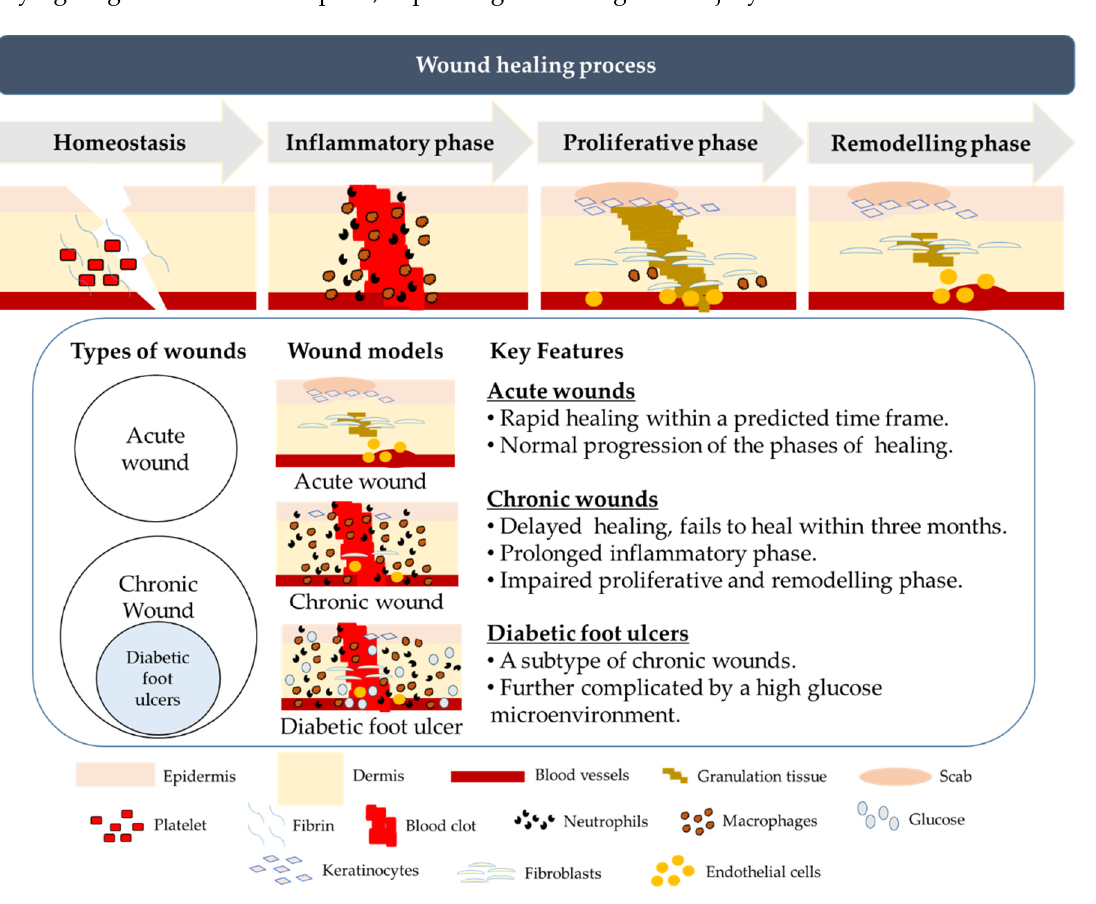
Figure 1. An illustration of the different phases of cutaneous wound healing and the key differences between acute wounds, chronic and diabetic foot ulcers. In normal wounds, healing is initiated by hemostasis to minimize further blood loss, followed by the inflammatory phase to prevent microbial infection. In the proliferative phase, granulation tissue is formed accompanied by the proliferation of epidermal keratinocytes and dermal fibroblasts, facilitating the final phase of tissue remodeling to restore the structure and function of the skin. Wounds can be classified as acute and chronic. Acute wounds heal rapidly within a short time frame with normal progression of the phases of healing, while chronic wounds take more than three months to heal due to a prolonged inflammatory phase and impaired proliferative and remodeling phases. Diabetic foot ulcers exhibit similar characteristics as other chronic wounds, but the healing of diabetic foot ulcers (DFUs) is further complicated by a sustained high glucose microenvironment.